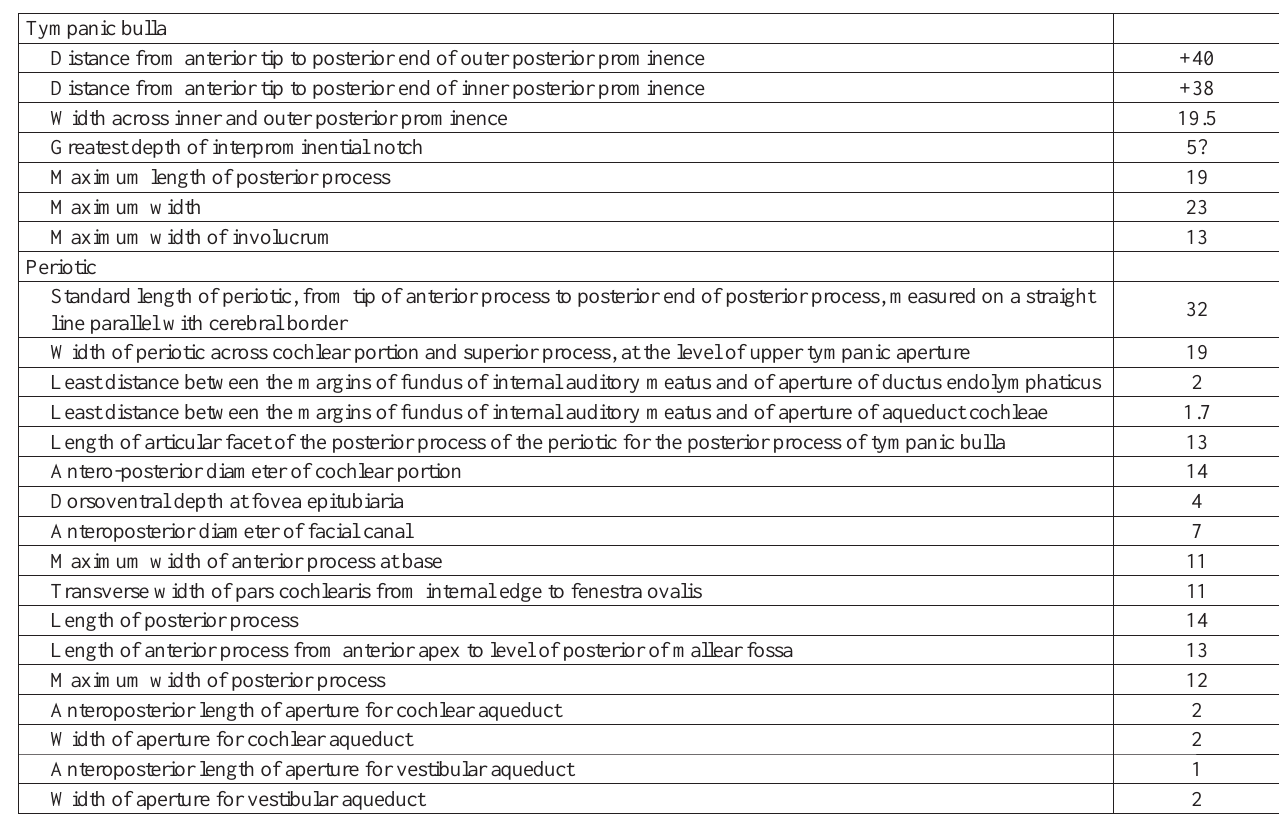
Table 1. Measurements (in mm) of left tympanic bulla and periotic of Aondelphis talen gen. et sp. nov., MPEF-PV 517 (after Kasuya 1973). + nearly complete; ? uncertainty in the measurement